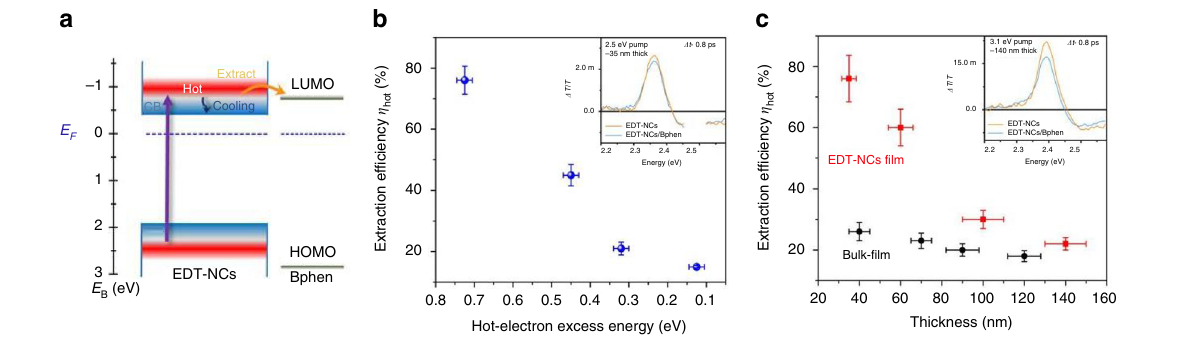
Fig. 14 HC extraction by using extremely thin absorber (B-Phen) as energy- selective contact. a The schematics of HC generation and their extraction with an illustration of the fl at energy band alignment of B-Phen absorber and perovskite NCs. b the dependence of the pump energy on HC extraction using a 35 nm thin B-Phen layer in which hot electrons with higher excitation energy can be extracted ef fi ciently. c The HC extraction ef fi ciency versus the B-Phen layer thickness for both the perovskite bulk fi lm and NCs at 3.1 eV photoexctation. Higher extraction of HC was observed for NCs. The fi gures are taken with permission from ref.